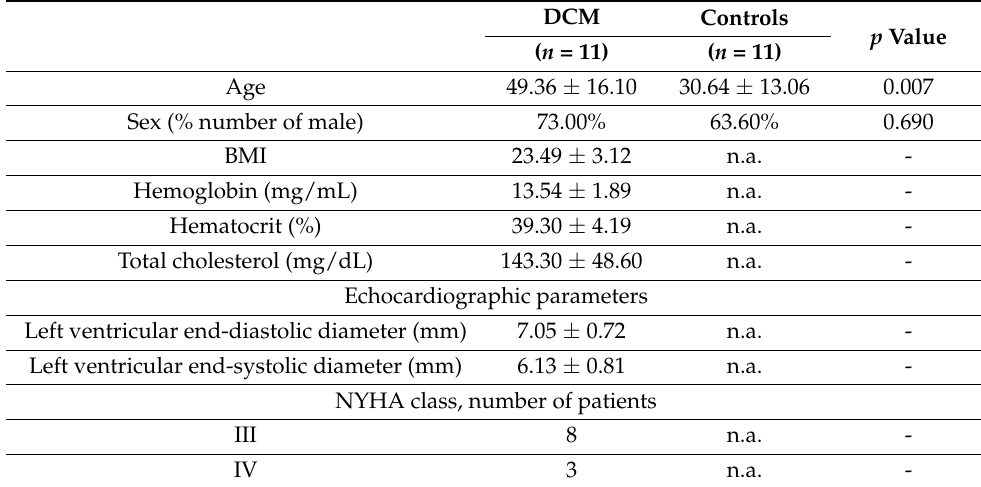
Table 2. Clinical characteristics of